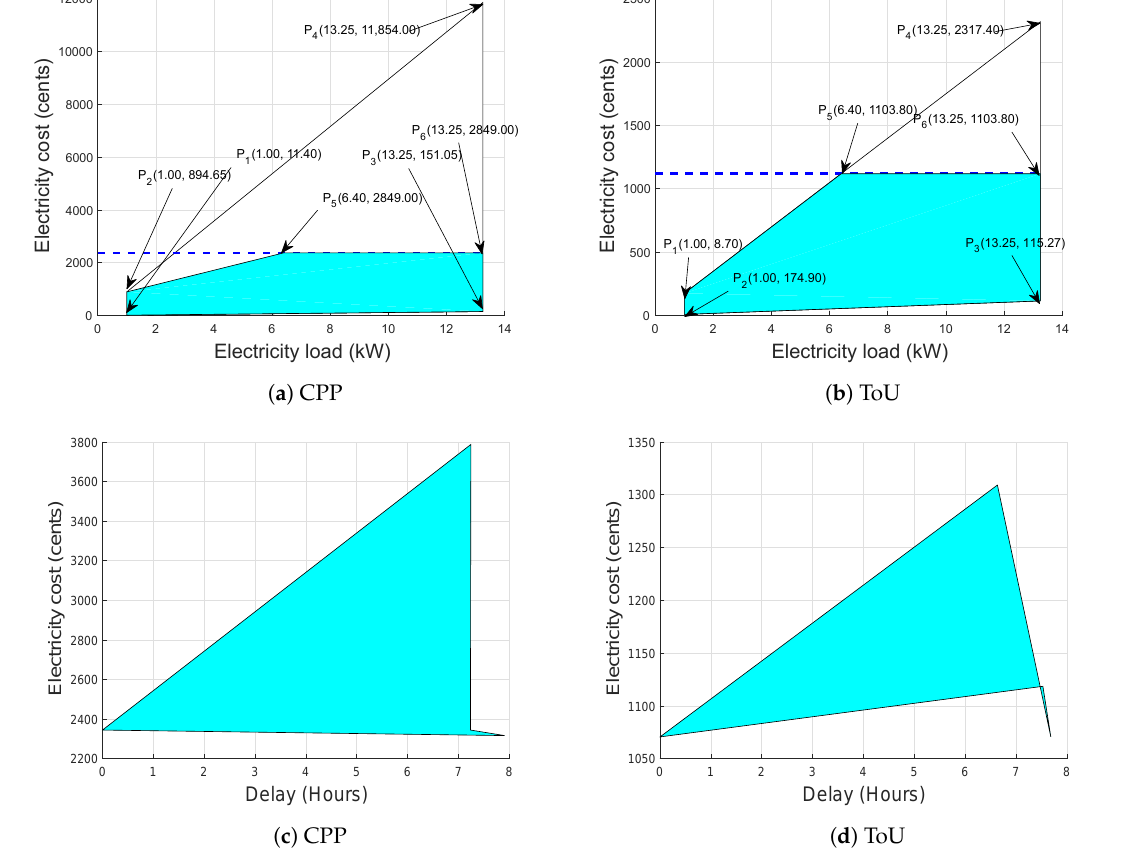
Figure 9. ( a ) FR for cost and electricity consumption using CPP; ( b ) FR for cost and electricity consumption using TOU; ( c ) FR for cost and waiting time using CPP; ( d ) FR for cost and waiting time using